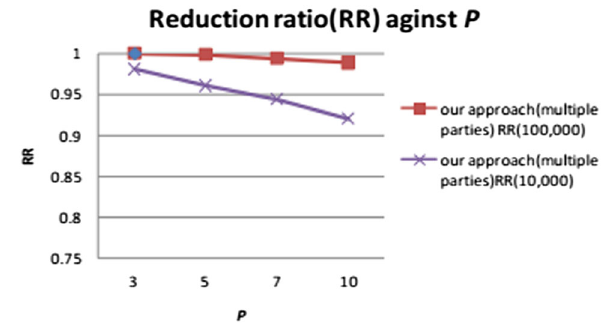
Fig. 11 ( RR with varying p for multi-part private